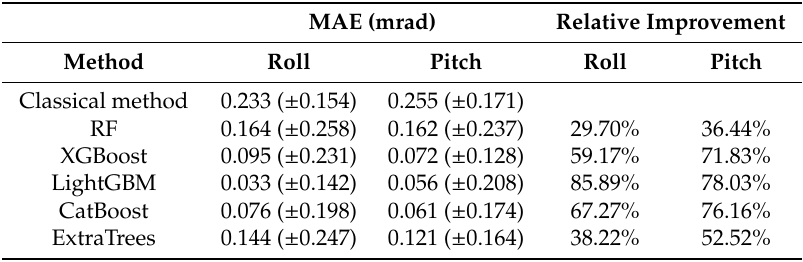
Table 7. CA errors in narrow range experiment for 1 s prediction time.